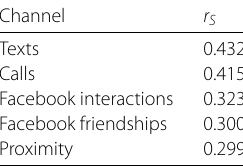
Table 2 Correlation between the cumulative GPA of the students and the mean cumulative GPA of their peers based on different communication channels. Corresponding p -values are below